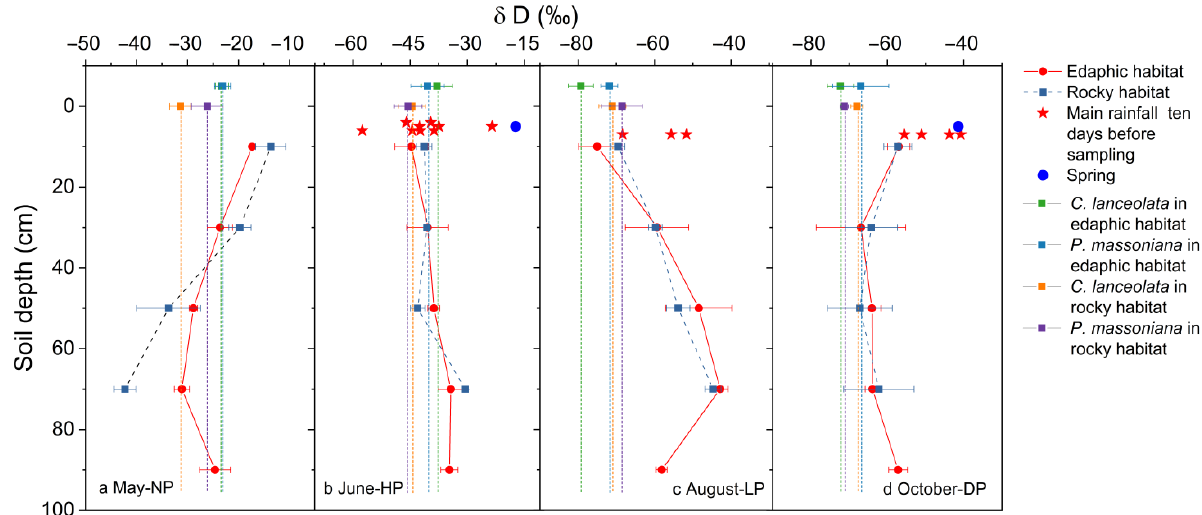
Figure 3. Variation in mean (± S.D.) δD of soil water with the soil profile, precipitation, spring, and xylem water during the wet season ( a ) May sampling; ( b ) June sampling; ( c ) August sampling; ( d ) October sampling).